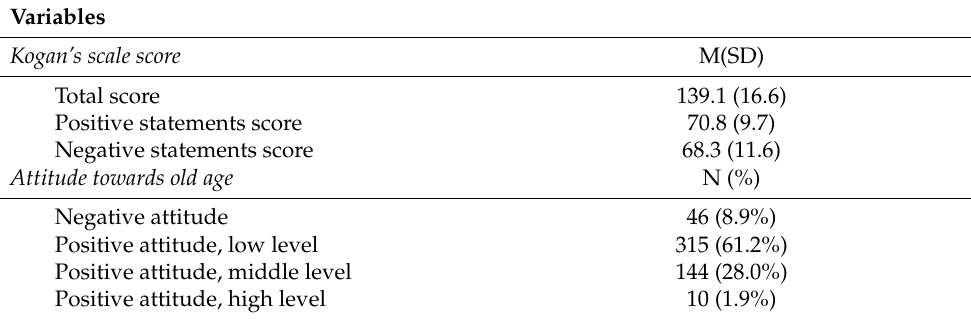
Table 1. Kogan’s scale scores and attitudes towards old age.